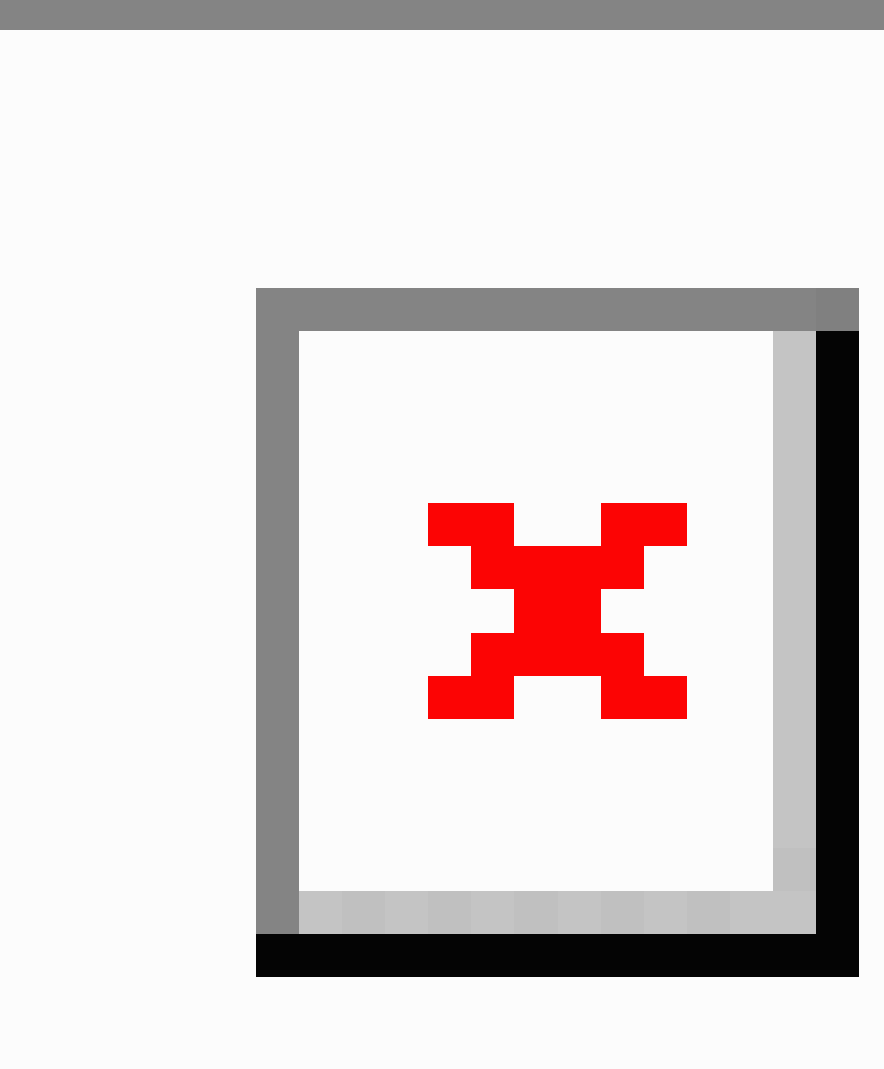
Figure 1. Screenshot of Kysylastenlaakarilta Facebook